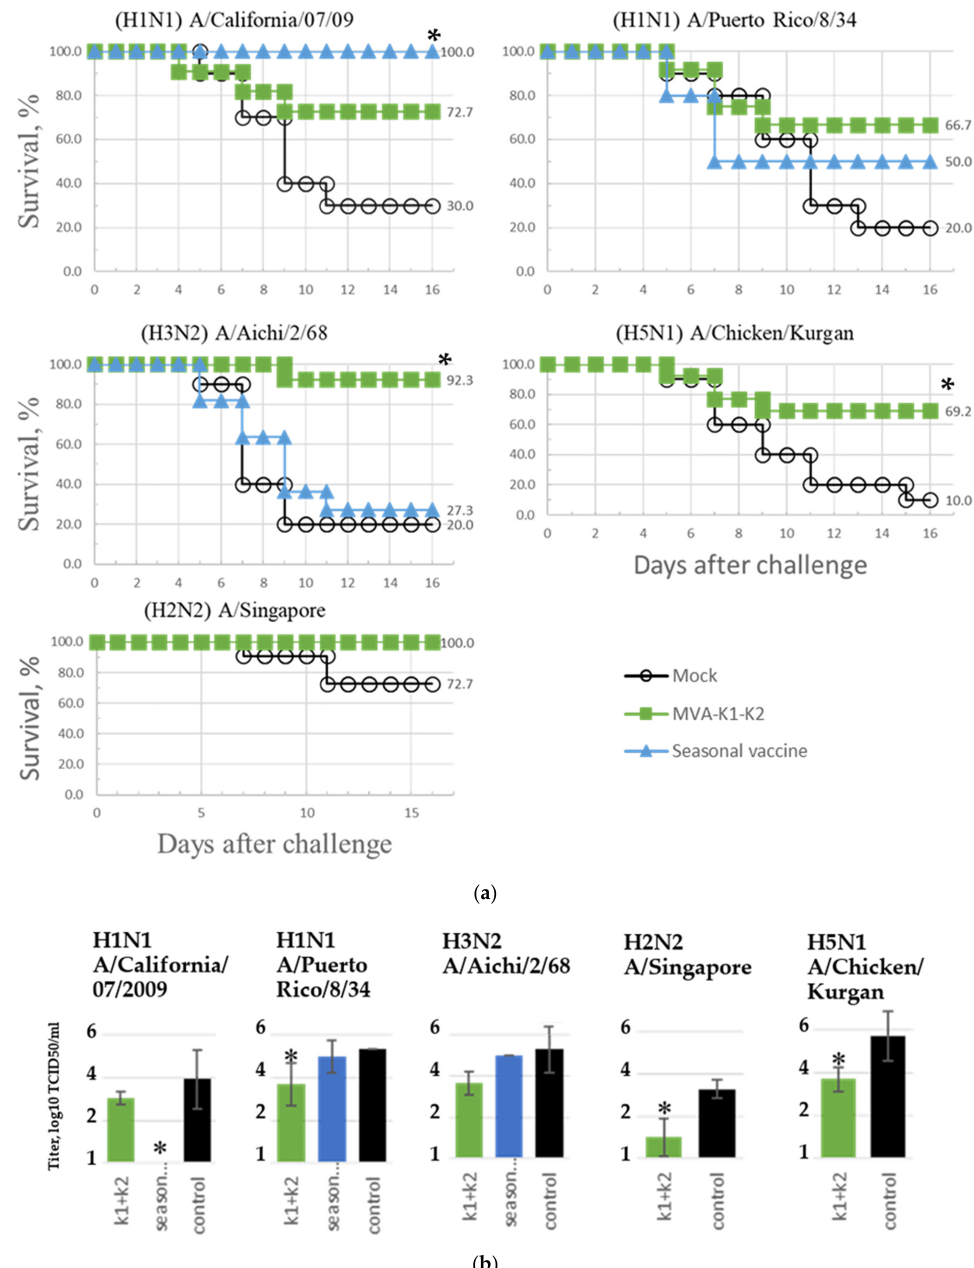
Figure 4. Results of infecting animals with different viral strains after immunization with rMVA-k1-k2, seasonal vaccine or PBS (Mock). Significance compared to control (mock): * p -value < 0.05. ( a ) Kaplan– Meier survival analysis (10 to 14 mice per infected group). ( b ) Viral titers (log 10 TCID 50 / mL ) in the lungs, mean value ( n =